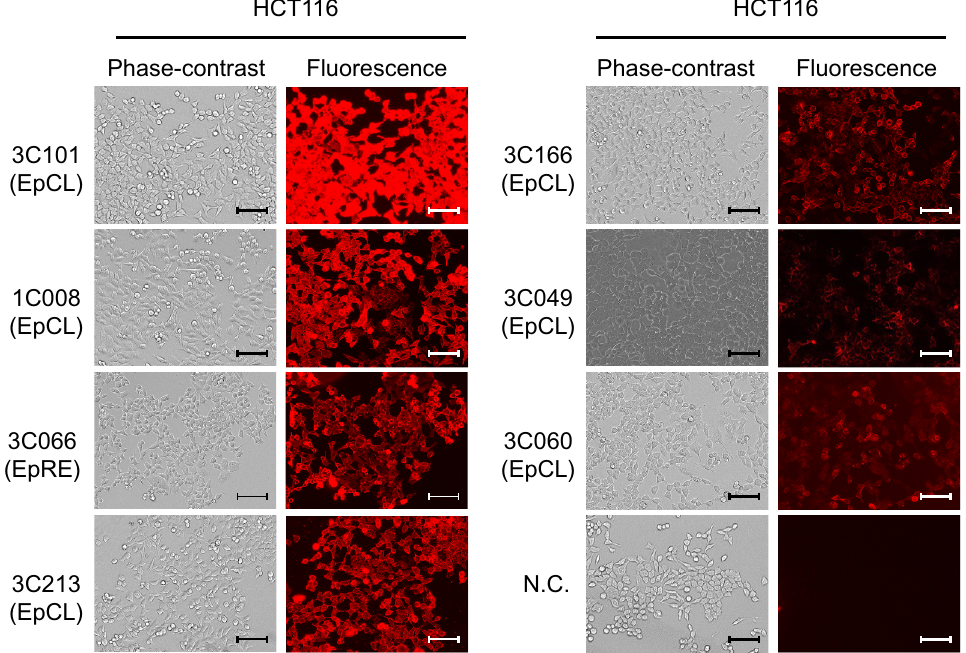
Figure 3. Assessment of anti-epithelial adhesion molecule (EpCAM) fully human monoclonal antibodies. Immunocytochemistry (ICC) of selected mAbs against unfixed HCT116 cells. HCT116 cells were stained with 5 μg/mL mAb. Scale bar = 100 μm. Magnification × 40. The clone number of the analyzed mAb is indicated in the upper left of each figure, and the area of the EpCAM extracellular domain recognized by the mAb is shown in